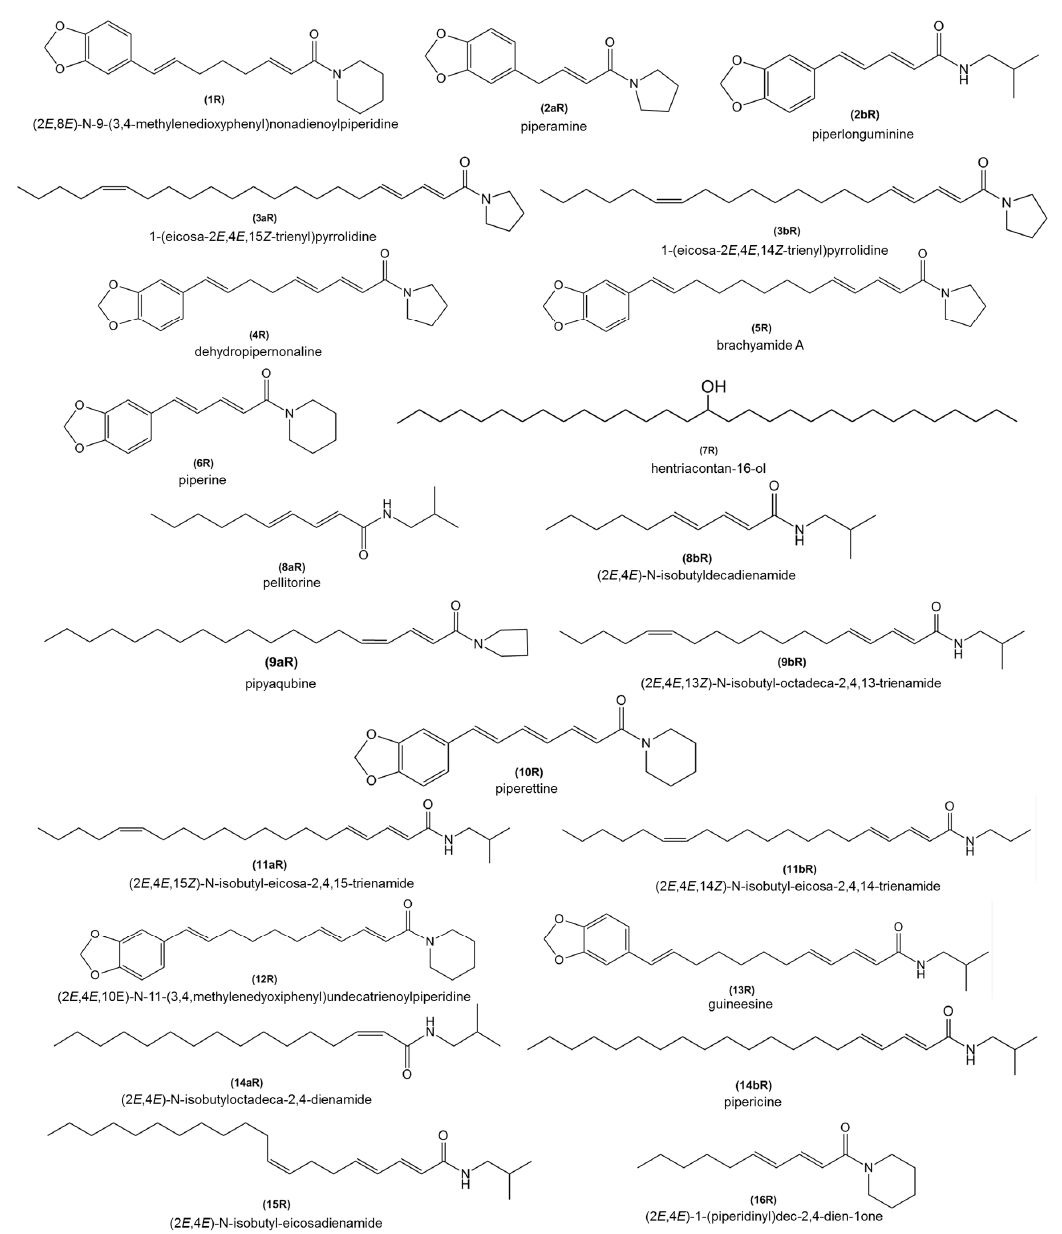
Figure 4. Identified compounds in roots of P. nigrum cv. Bragantina and Cingapura during infection with F. solani f. sp. piperis .